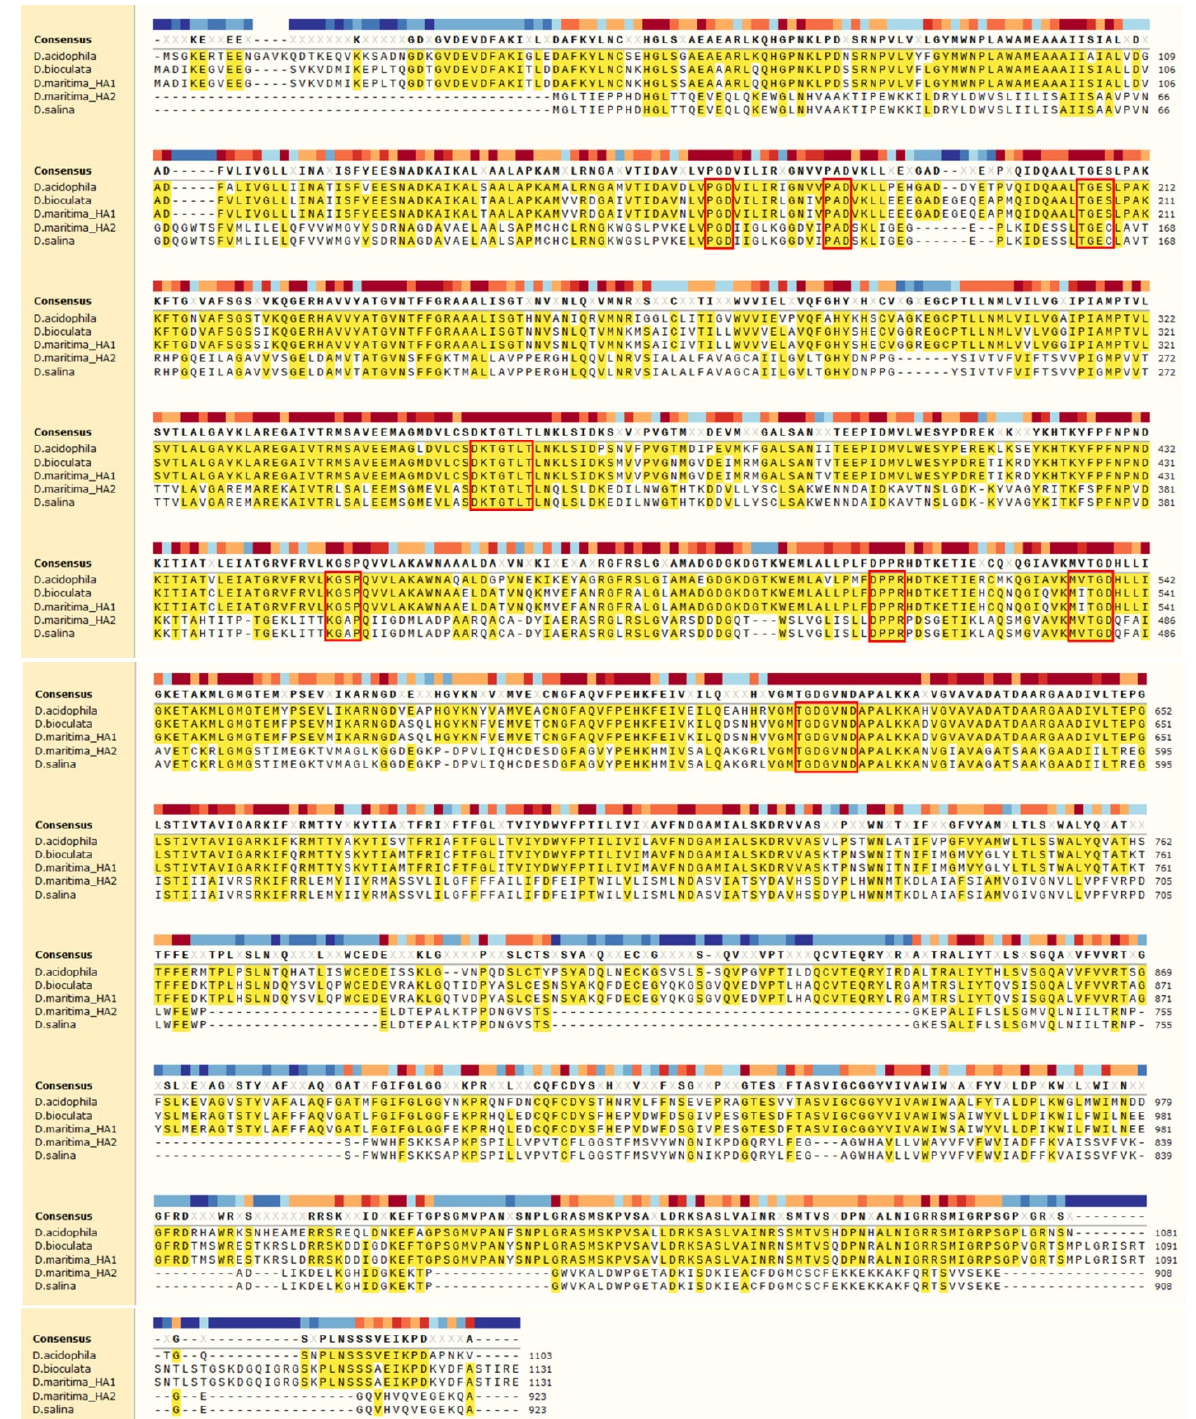
Figure 1. Multiple alignment of aa sequences of ATPases from Dunaliella species. The identical amino acids are shown in yellow background, and the conserved amino acids in P-type ATPases are highlighted by frames. The proteins for alignment: D. acidophila , P54210.1; D. bioculata , P54211.1; D. maritima _HA1, QEH60479.1; D. maritima _HA2, AQM50087.1; D. salina , ABB88698.1.